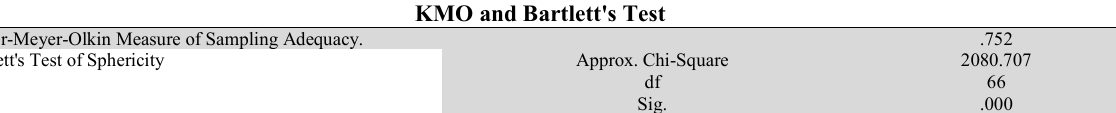
KMO and Bartlett's Test